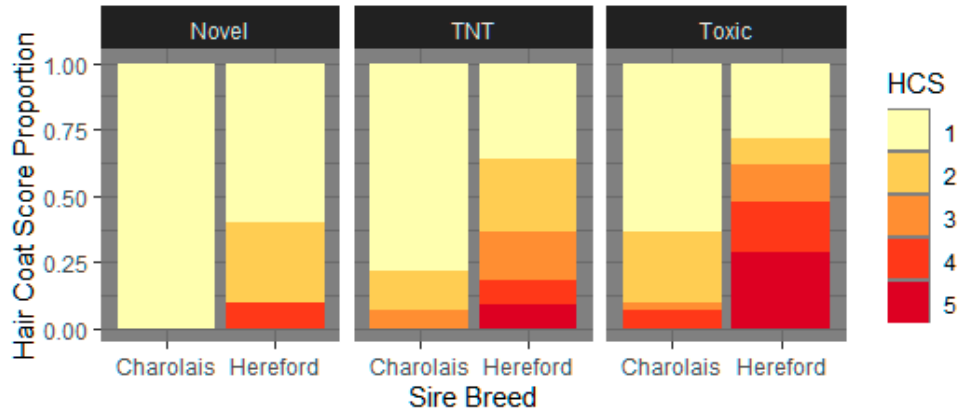
Figure 1. August hair coat scores (HCS) differ by fescue pasture type and sire breed. Cow HCS were evaluated using the scoring system described by [30] [1 = slick summer coat (100% shed) to 5 = full, thick winter coat (0% shed)]. The proportion of August (heat stressed/end of trial) HCS classifications by sire breed (Charolais or Hereford) and fescue exposure type (novel, toxic-novel rotation (TNT), or toxic) were significant ( p < 0.002 and p < 0.0001, respectively) when March (cool weather/beginning of trial) HCS were modeled as covariates to adjust for initial variable in hair.